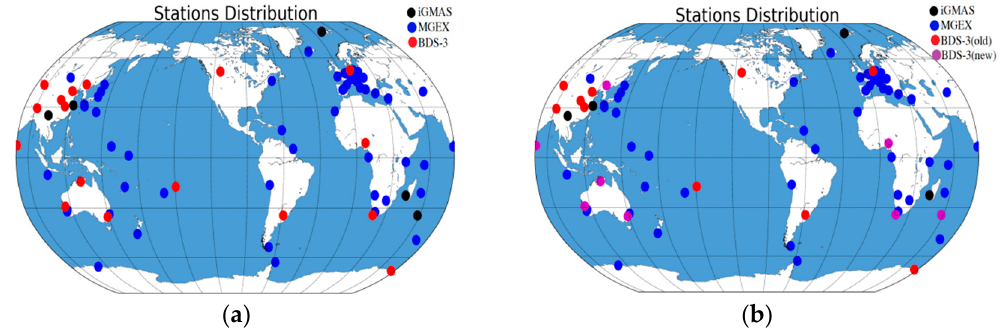
Figure 7. Stations distribution of BDS-3 experimental satellites orbit determination (black: iGMAS stations without BDS-3 observations; red: iGMAS stations with BDS-3 observations; blue: MGEX stations; and magenta: increased iGMAS stations with BDS-3 observations). ( a ) Stations distribution at the beginning, ( b ) Stations distribution at the end. Table 5. Parameter configurations for BDS-3 experimental satellite orbit determination.